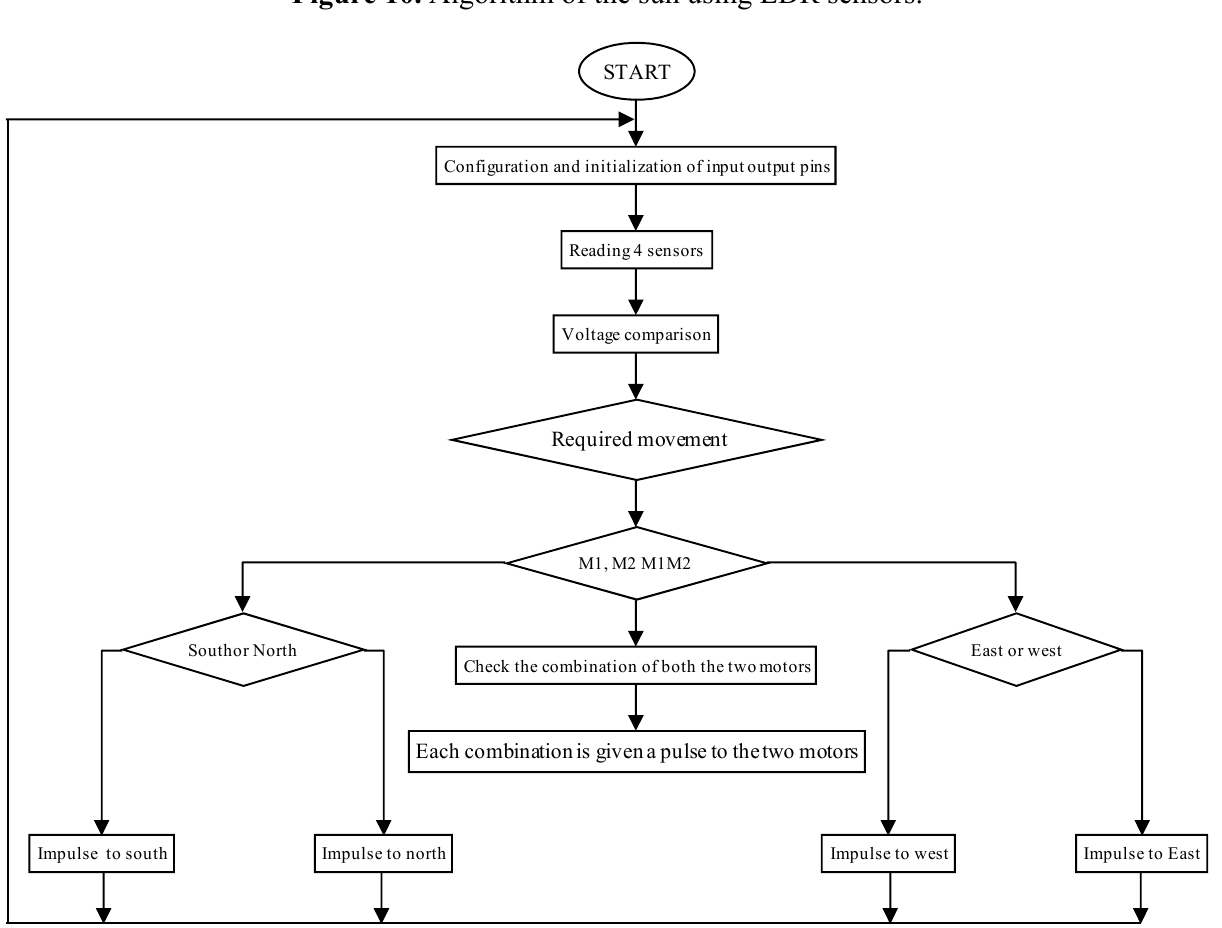
Figure 10. Algorithm of the sun using LDR